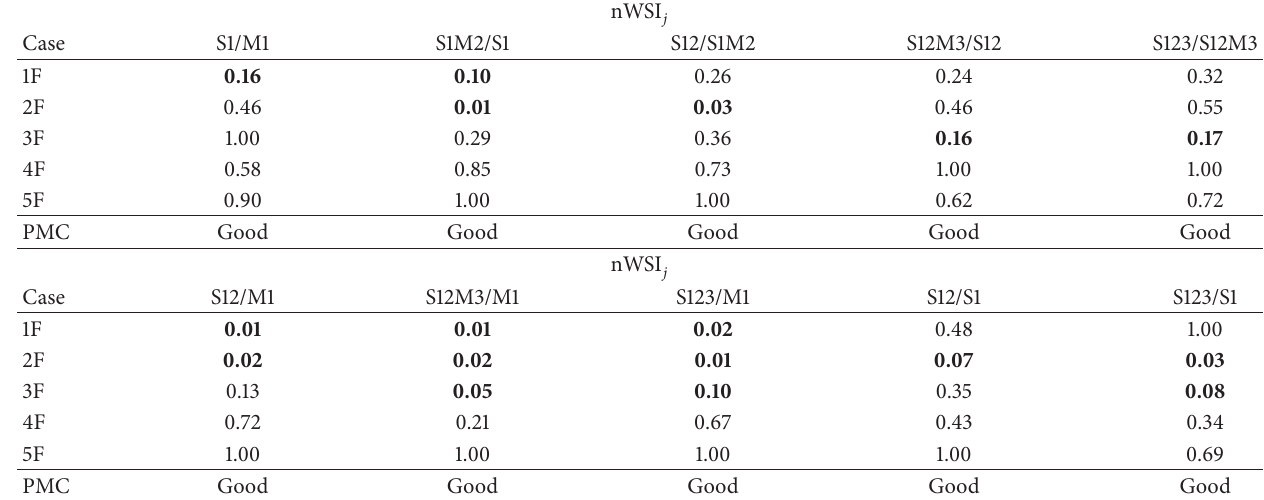
Table 5: Damage assessment of ill-conditioned structures